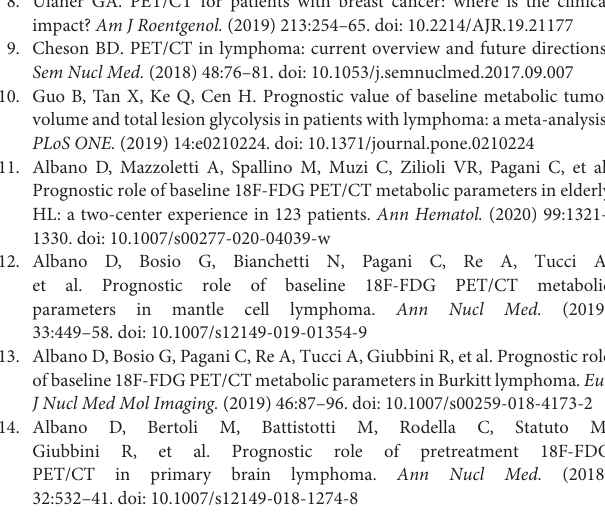
Supplementary Figure 1 | Boxplot showing the distribution of the Dice scores for the research cohort (DLBCL) and for the routine cohort (miscellaneous, lung cancer, and